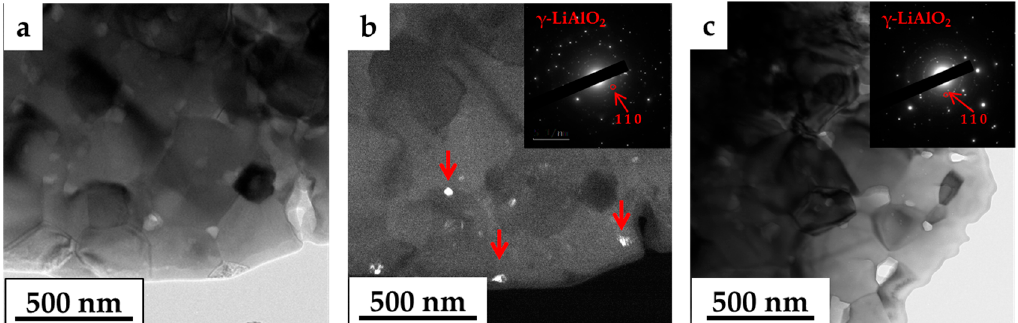
Figure 9. BF-TEM image of SPS spinel samples doped with 0.20 at. % Li after heat treatment at 1450 °C for 24 h ( a ); the white particles in the DF-TEM image are the γ -LiAlO 2 phase ( b ); BF-TEM image of spinel samples doped with 0.20 at. % Li after heat treatment at 1450 °C for 72 h ( c ); the selected area diffraction patterns indicate the reflection of (1 1 0) of the γ -LiAlO 2 phase.